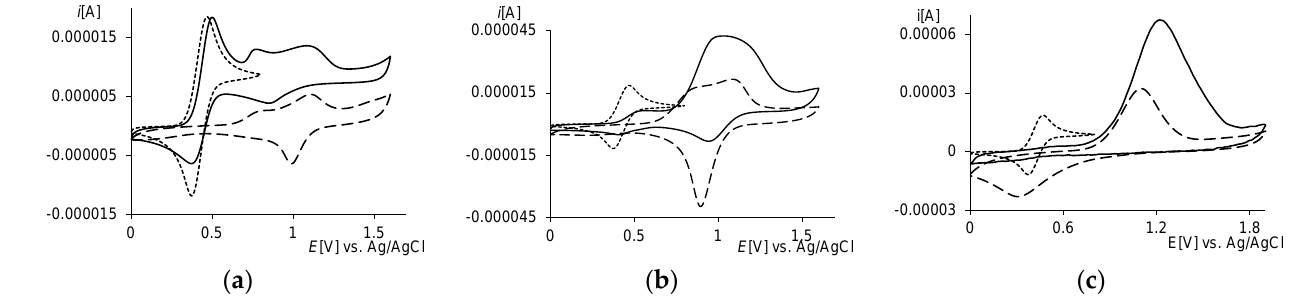
Figure 1. Cyclic voltammograms, 2nd scans, v = 0.05 V · s − 1 , vs. Ag/AgCl. Pt poly [Ni(salcn)] in TBAH (0.1 mol · dm − 3 )/CH 2 Cl 2 —dashed lines, Pt poly [Ni(salcn)] in ferrocene (10 − 3 mol · dm − 3 )/ TBAH/CH 2 Cl 2 —solid lines; Pt in ferrocene/TBAH/CH 2 Cl 2 —dotted lines: ( a ) after electropoly- merization: 3 scans, v = 0.5 V · s − 1 ; ( b ) after electropolymerization: 3 scans, v = 0.05 V · s − 1 ; ( c ) after electropolymerization: 3 scans, v = 0.005 V · s − 1 .